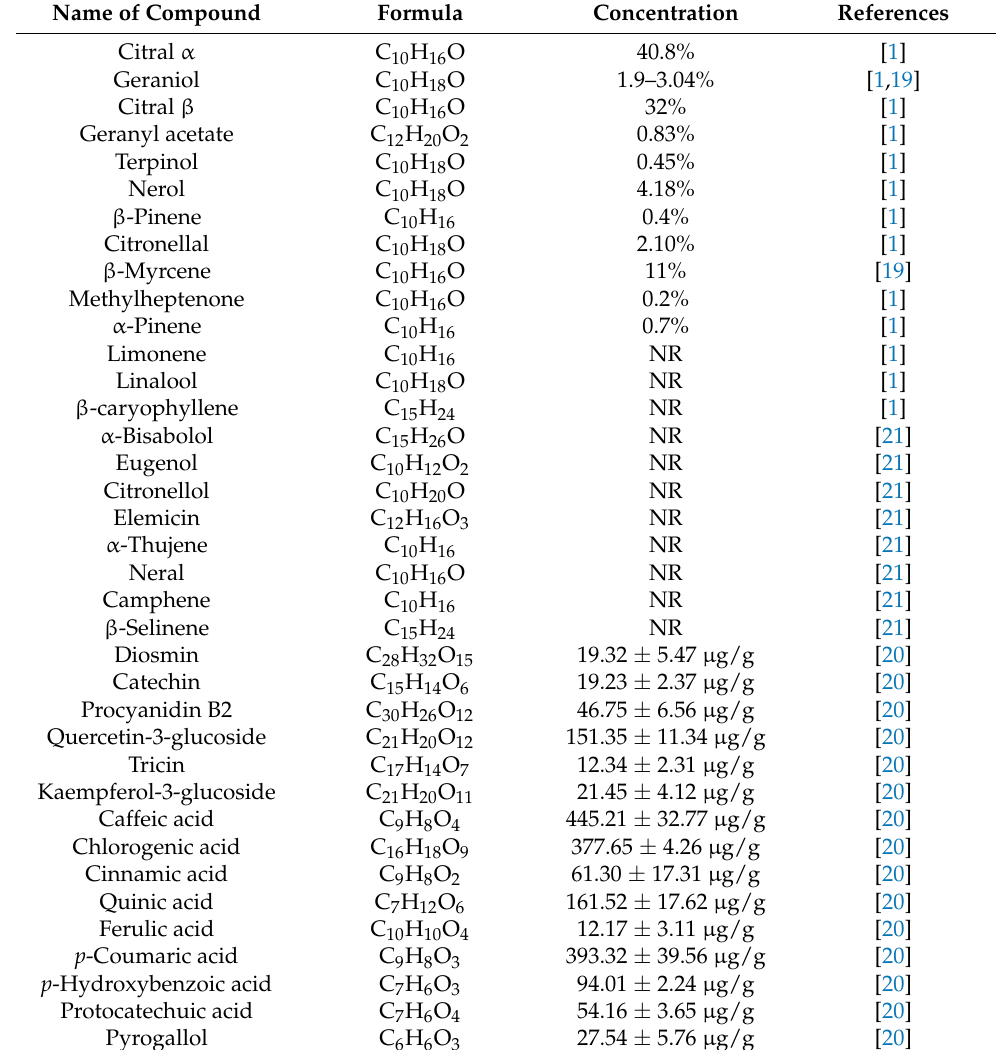
Table 1. Phytochemical constituents of lemongrass.